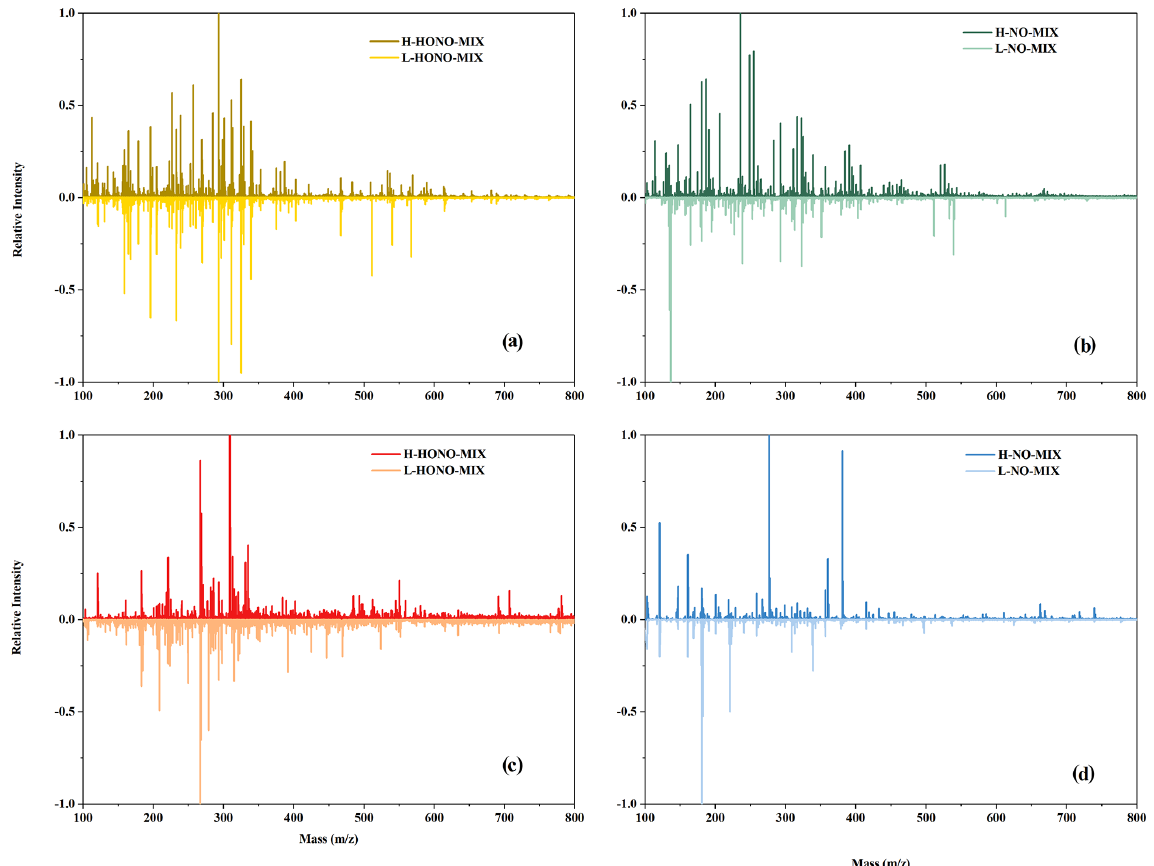
Figure 7. Mass spectra of mixture experiments: (a) HONO mixture experiments in negative mode, (b) NO mixture experiments in negative mode, (c) HONO mixture experiments in positive mode, and (d) NO mixture experiments in positive mode. The y axis is the relative intensity normalised by dividing by the maximum signal strength of the mass